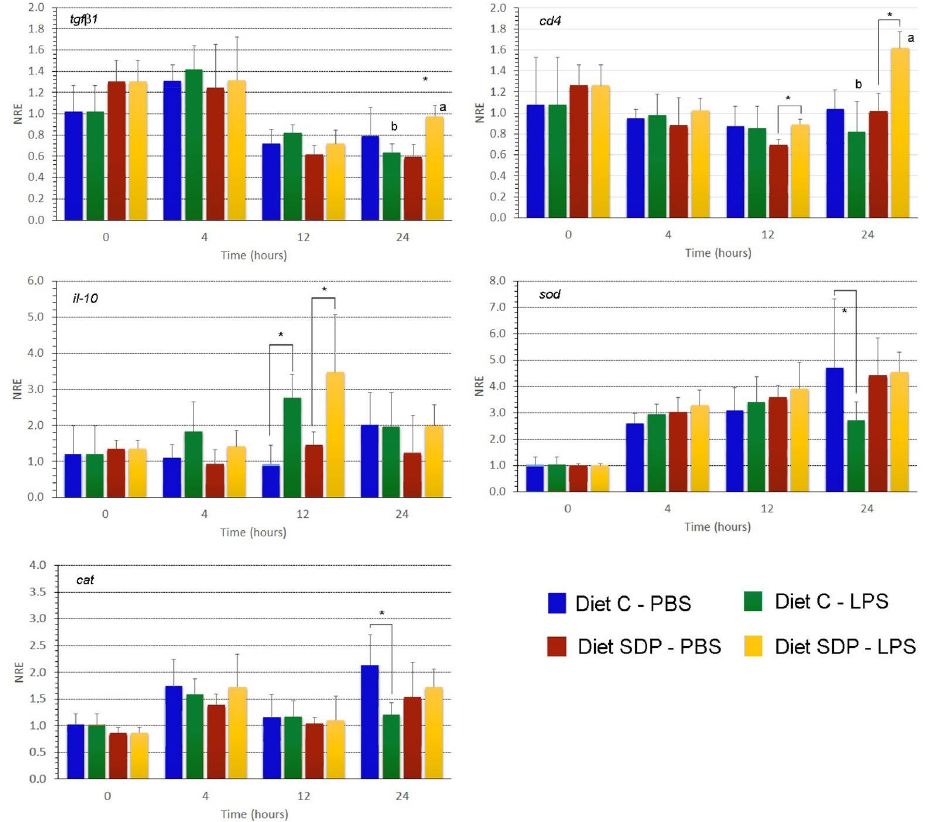
Figure 3. Gene expression analysis of anti-inflammatory, surface, and anti-oxidative markers mea- sured in primary cultures of splenocytes incubated with PBS or LPS. The gene expression ( n = 6) of anti-inflammatory cytokines ( il-10 , tgf β 1 ), the surface marker cd4 and antioxidative stress enzymes ( sod , cat ) was evaluated in splenocytes of gilthead sea bream ( Sparus aurata ) fed a control diet (Diet C) with very low levels of fishmeal (7%) and a diet in which 5% fishmeal was replaced with spray- dried porcine plasma (SDPP diet). The gene expression profile was measured in primary cultures of splenocytes from both groups exposed to PBS and LPS at different sampling times (0, 4, 12 and 24 after LPS or PBS incubation). The analysis used the β -actin gene as the reference. Data were compared by means of a two-way ANOVA. Different letters denote statistically significant differences between splenocytes from different groups (C and SDPP diets) at the same sampling time. The asterisk indicates the presence of statistically significant differences between splenocytes incubated with PBS or LPS within the same experimental group ( p <